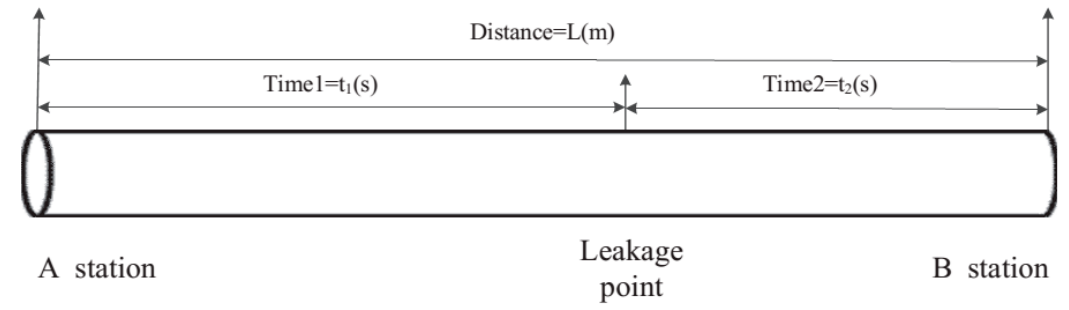
Figure 8. Negative pressure wave monitoring system [147].